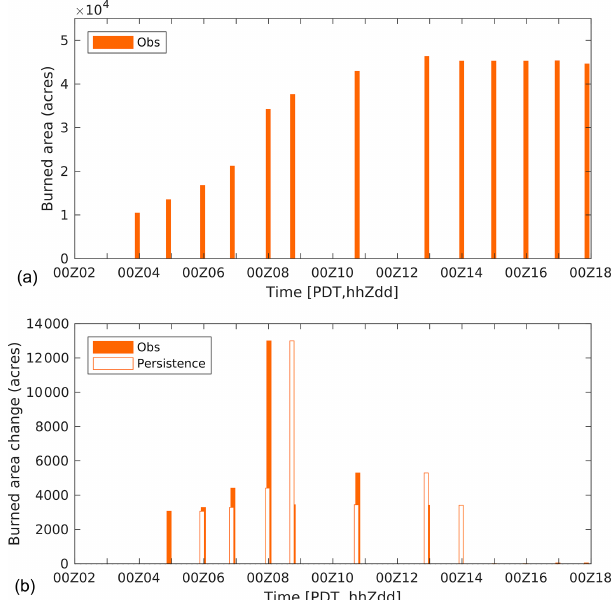
Figure 2. Time series of burned area from the NIROPS IR obser- vations for the Williams Flats fire on 2–17 August 2019 (a) and day-to-day increment of burned area on 4–9 August (b) . The obser- vation hour and day are shown in PDT (UTC − 7) in “hhZdd” (hour and day). Daily increments of burned area based on the assumption of persistent fire activity are shown by the open orange bar in the lower panel; they are equal to the observed value on the previous